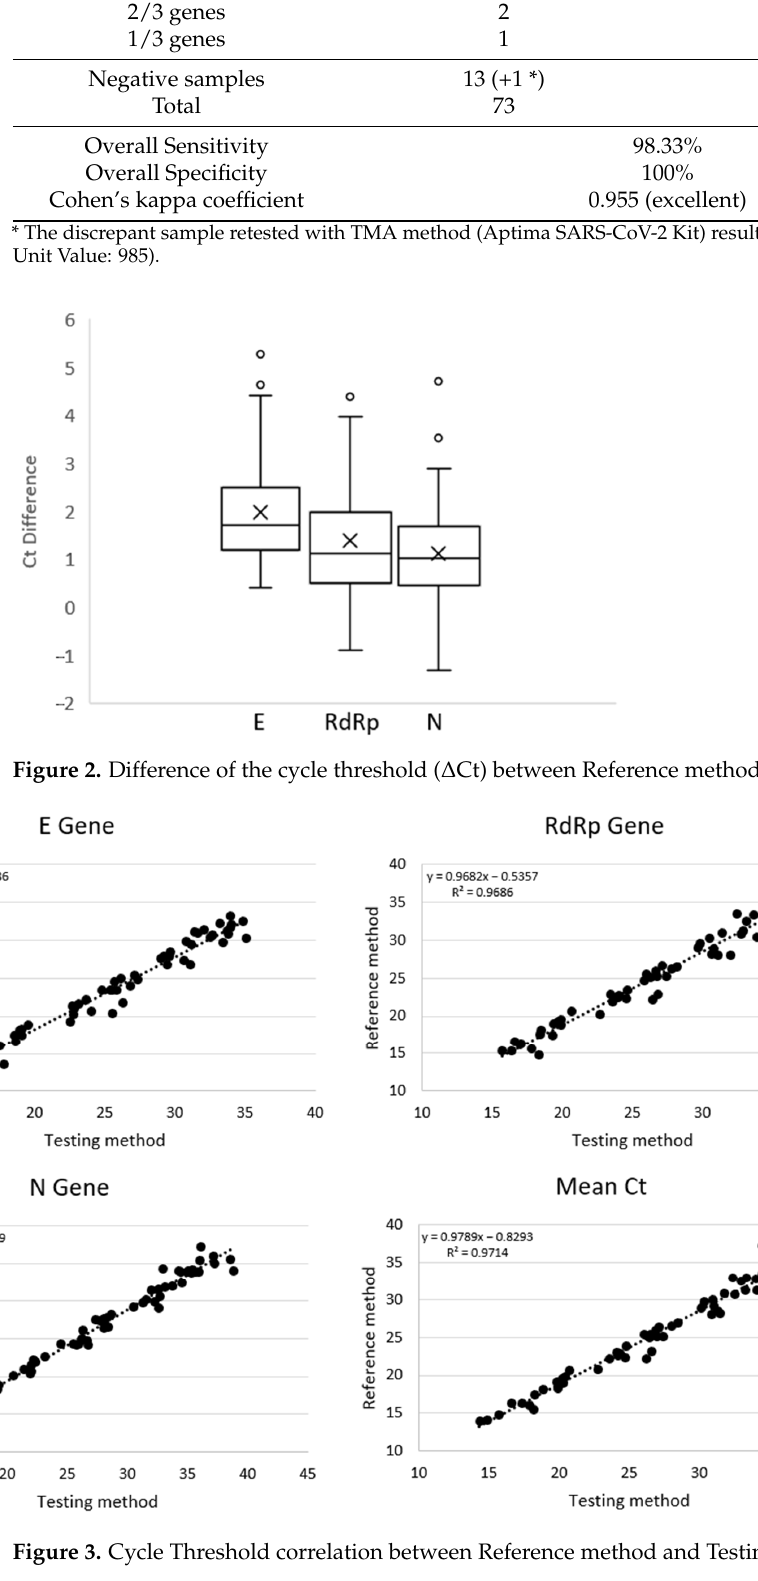
Table 1. Clinical performances of Testing method and Reference method.